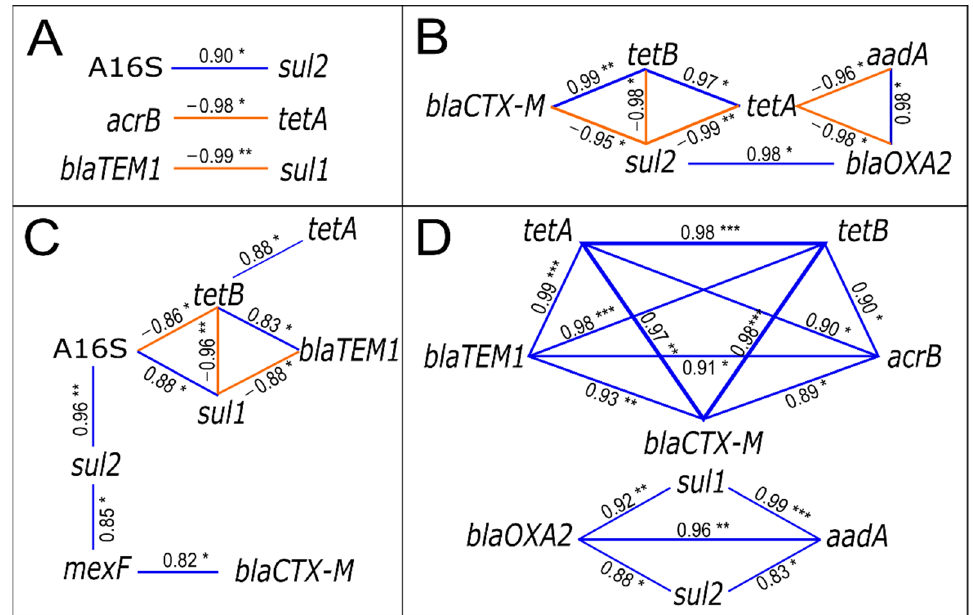
Figure 4. Statistically significant partial correlations of quantified abundances of antibiotic resistance genes (ARG) in the stream and river water ( A ) and stream and river sediments ( B ). The abundances of bacterial- and archaeal-specific 16S rRNA genes (B16S and A16S, respectively) are used as covariables. In case of A16S, the correlations with ARGs are shown and B16S is used as a covariable. The statistically significant Pearson correlations between relative abundances of ARGs (and A16S) in prokaryotic communities of the stream and river water ( C ) and sediments ( D ) are shown. * p < 0.05; ** p < 0.01; *** p <